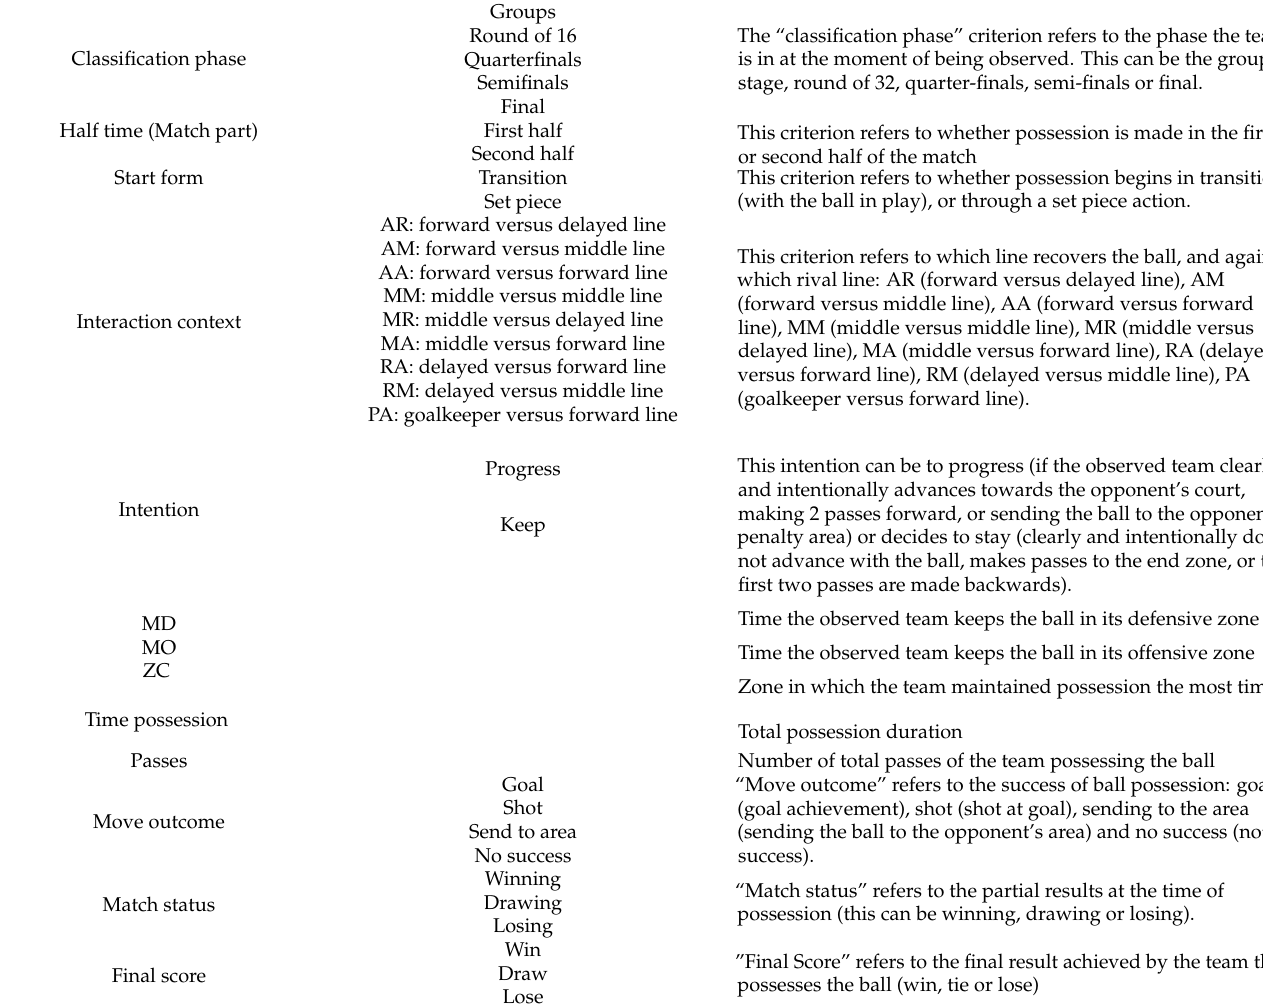
Table 1. Dimensions that are part of the ad hoc instrument and derived category